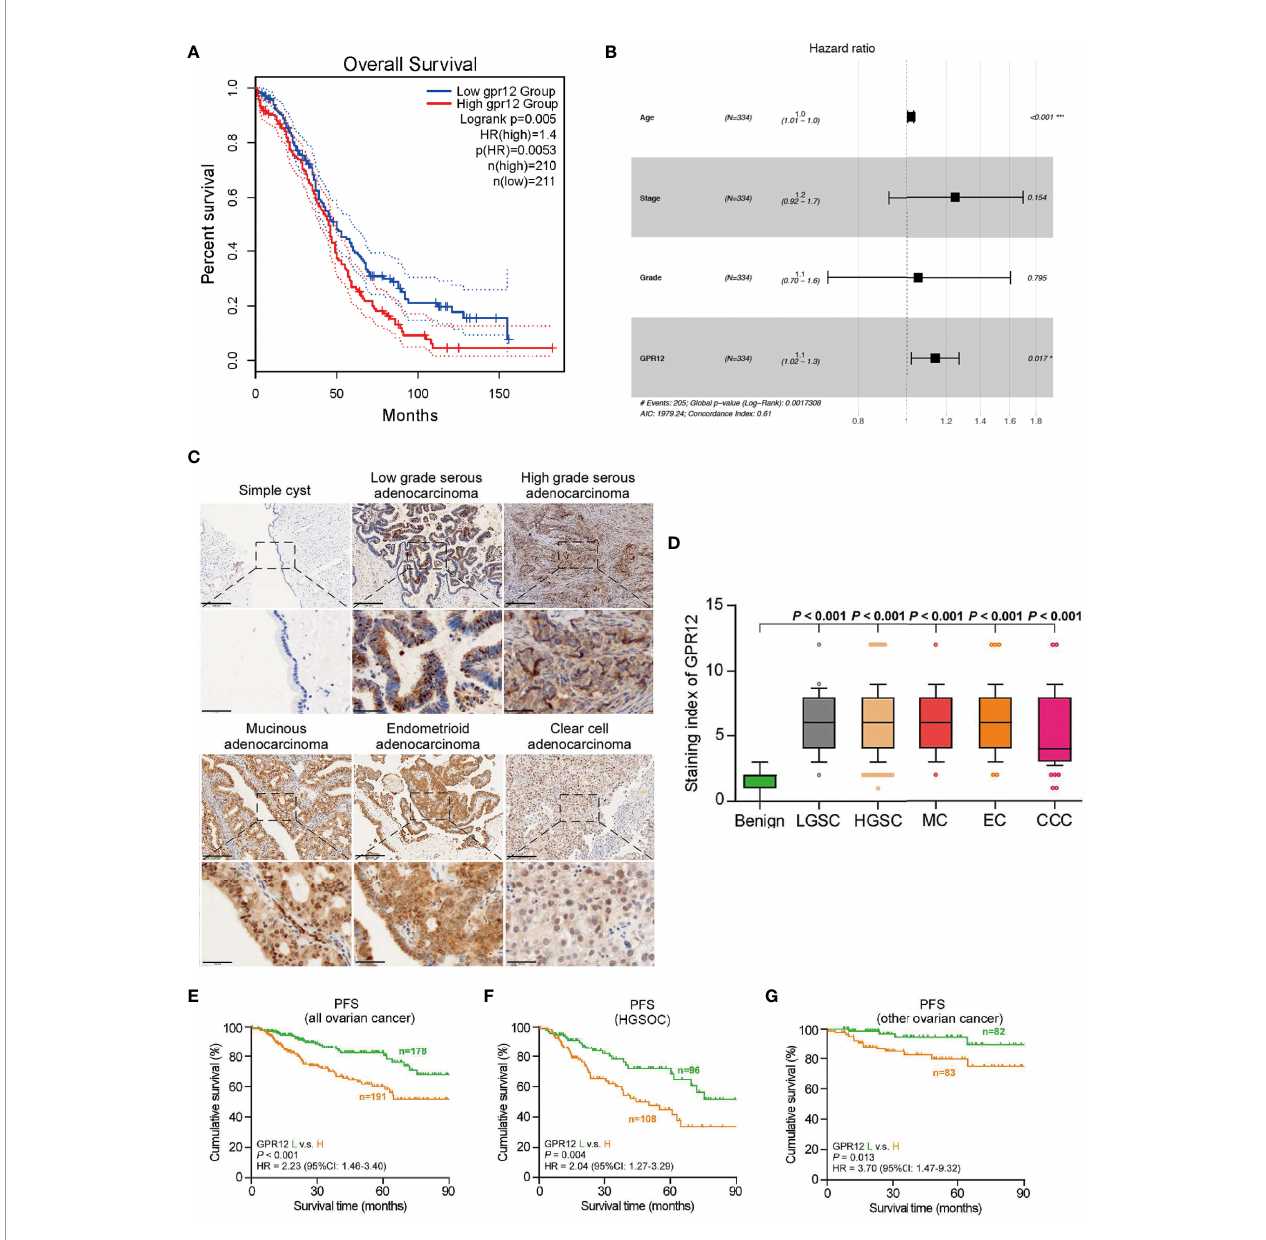
FIGURE 1 | GPR12 is overexpressed in the EOC and predicts the prognosis of patients with EOC. (A) Association of GPR12 expression with overall survival (OS) was evaluated using Kaplan – Meier analysis in patients in the TCGA EOC database. (B) Multivariate Cox analysis of GPR12 and clinical phenotype characters in TCGA-OV database. (C) GPR12 expression in clinical samples was stained by immunohistochemistry (IHC). Scale bar = 200 m m in the upper panels and 50 m m in the below panels. (D) GPR12 expression was signi fi cant higher in different histological types of EOC. (E – G) Association of GPR12 expression with progression-free survival (PFS) was evaluated using Kaplan – Meier analysis on 369 patients with